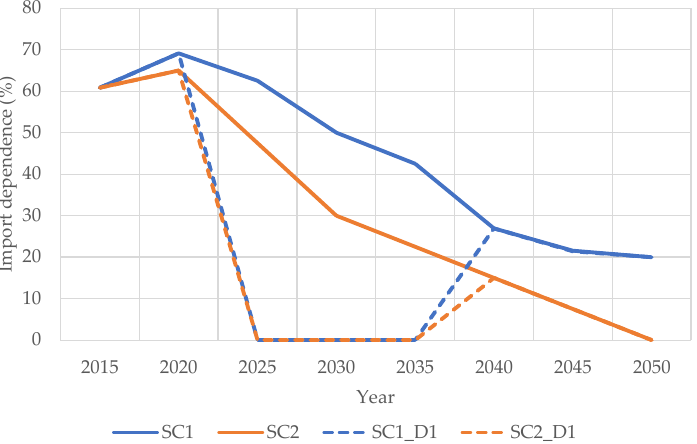
Figure 3. Import dependence (%) in the case of the loss of all electricity import sources. Change in energy system total costs was also evaluated during the disruption time frame (Figure 4). Over time, the indicators increase since relatively cheaper electricity im- ports are replaced due to unavailability with technologies that produce electricity at higher costs. Figure 4. Cost change (%) in the case of the loss of all electricity import sources. Figure 4. Cost change (%) in the case of the loss of all electricity import SC1 demonstrates less resilience to cost changes than SC2 when all electricity import sources are lost. In 2035, SC1 demonstrates an increase of ~33%, and in SC2, the increase is ~18% at the same time. The results for the estimated indicators demonstrate that over time, the analyzed en- ergy system tends to be more resilient to disruptions related to the loss of electricity im- ports. In both analyzed scenarios, a decrease in dependency on electricity imports is ob- served, and SC2 performs better since it assumes higher RES targets and is less dependent on electricity imports in comparison with SC1. 4.2.2. The Loss of Natural Gas Supply (D2) In this disruption scenario, the complete loss of natural gas supply for energy pro- duction is considered. In SC1 and SC2, electricity from natural gas is produced until 2030 (due to constraints on RES targets), and the share has a decreasing trend; therefore, this disruption does not significantly change the electricity mix. The shares of natural gas in electricity production in 2025 are approx. 2.1% in SC1 and 2.6% in SC2. The lost portion of natural gas for electricity production is simply replaced by electricity imports in the case of disruption from 2025. Unserved energy during the disruption period is not ob- served, and the change in total costs of the energy system reached a maximum value of 0.5% and is not analyzed in more detail. The estimates of these two indicators demonstrate high energy system resilience in both scenarios in the case of the loss of natural gas supply. However, this observation is applied only to the electricity system. The heating system is more impacted by this dis- ruption, but details are not analyzed since it is out of the scope of this study. Figure 5 shows the import dependency indicator, which in the case of the loss of nat- ural gas supply demonstrates that the energy system relies more on electricity imports during the disruption period. However, the difference is not significant since over time, the energy system in both scenarios is decreasingly dependent on electricity production from natural gas.